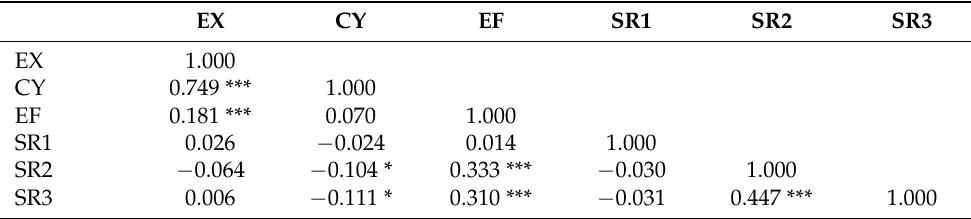
Table 8. Correlation matrix of academic burnout and academic resilience by subscales among respondents (N =